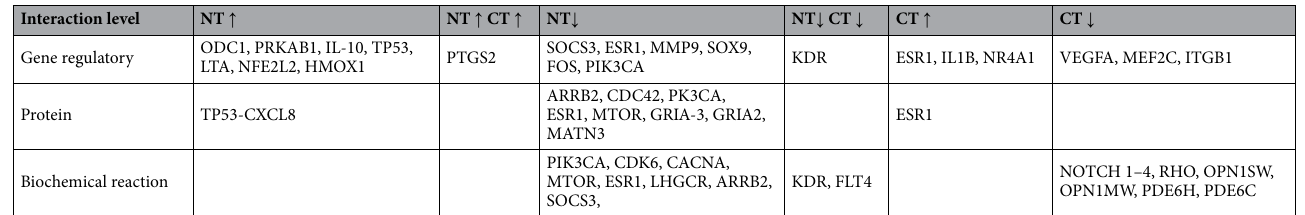
Table 1. Specific genes that can serve as biomarkers for studying toxicity in zebrafish ( Danio rerio ). Genes exclusively upregulated in Neurotoxicity (NT ↑ ); Genes upregulated in both Neurotoxicity and Cardiotoxicity (NT ↑ CT ↑ ); Genes exclusively downregulated in Neurotoxicity (NT ↓ ); Genes downregulated in both Neurotoxicity and Cardiotoxicity (NT ↓ CT ↓ ); Genes exclusively upregulated in Cardiotoxicity (CT ↑ ); Genes exclusively downregulated in Cardiotoxicity (CT ↓